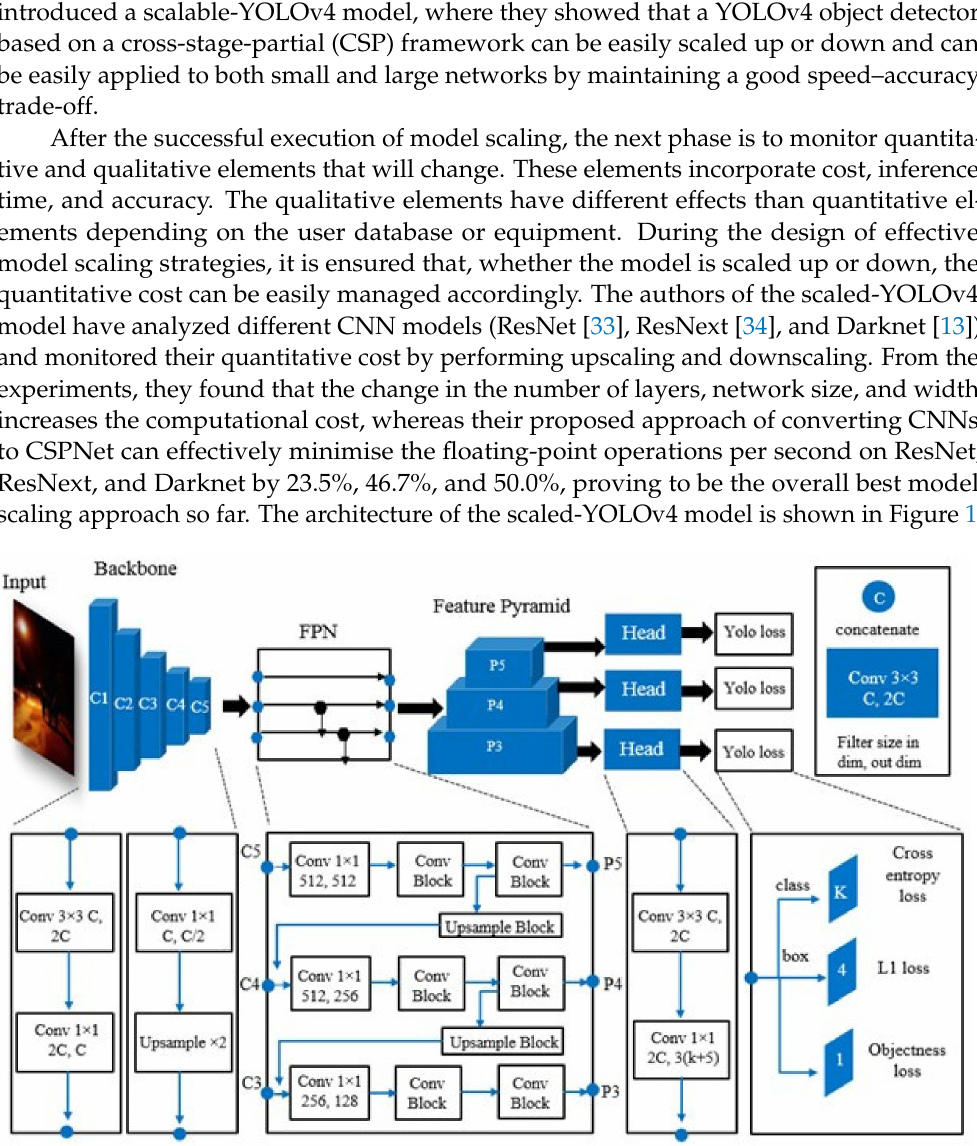
Figure 1. Diagrammatic representation of the scaled-YOLOv4